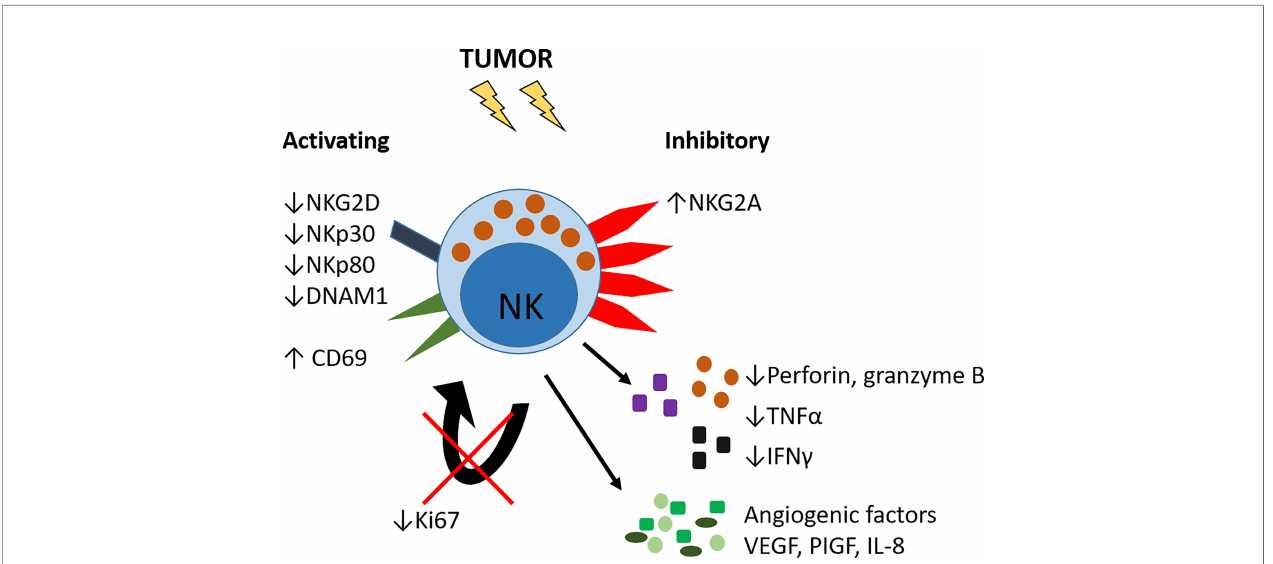
FIGURE 3 | Altered phenotype of lung tumor NK cells. NK cells in lung tumors have reduced expression of activating receptors including NKG2D, NKp30, NKp80 and DNAM1 and increased expression of the inhibitory receptor NKG2A. The activation marker CD69 is increased. Tumor NK cells have reduced expression of Ki67 and hence reduced proliferative capacity, and decreased expression of pro-in fl ammatory cytokines TNF a and IFN g , and decreased production of perforin and granzyme B. Lung tumor NK cells can also produce pro-angiogenic growth factors VEGF, PlGF and